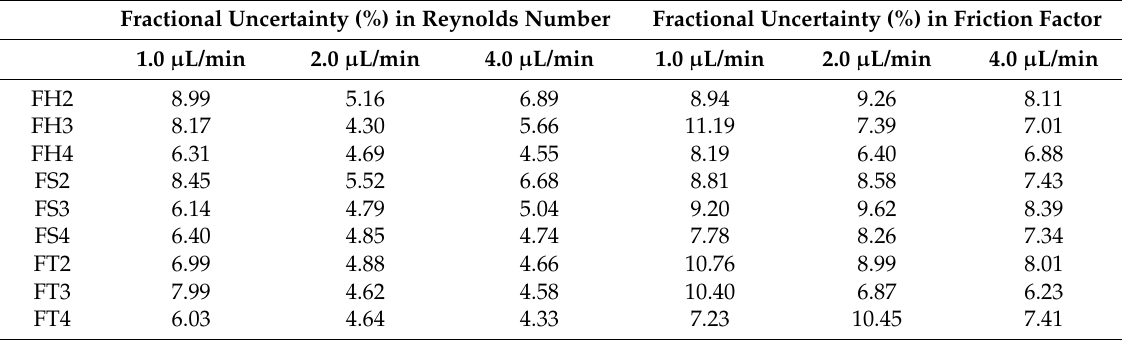
Table 4. Analysis of the fractional uncertainty in friction factor and Reynolds number.